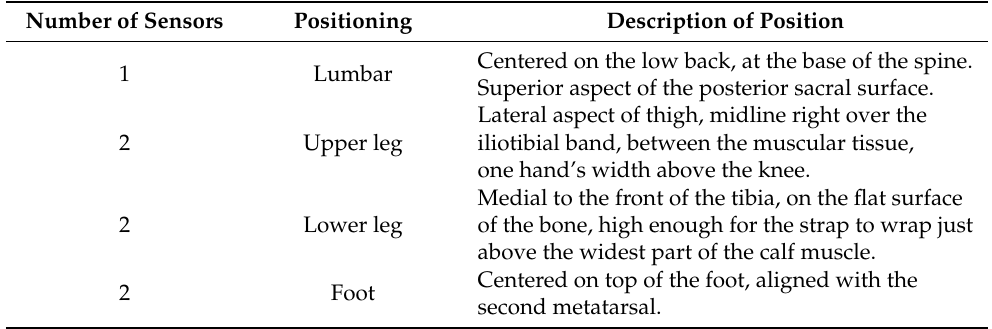
Table 1. Number of sensors, positioning, and description of position of the IMUs (Opal sensors) used. Number of